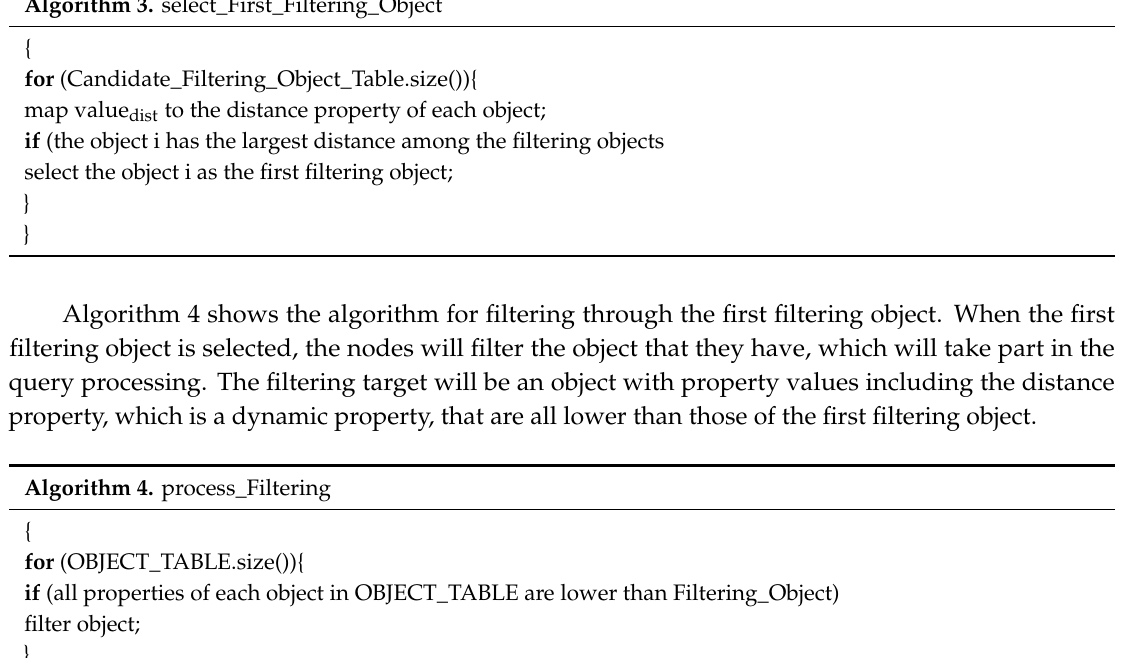
Algorithm 3. select_First_Filtering_Object